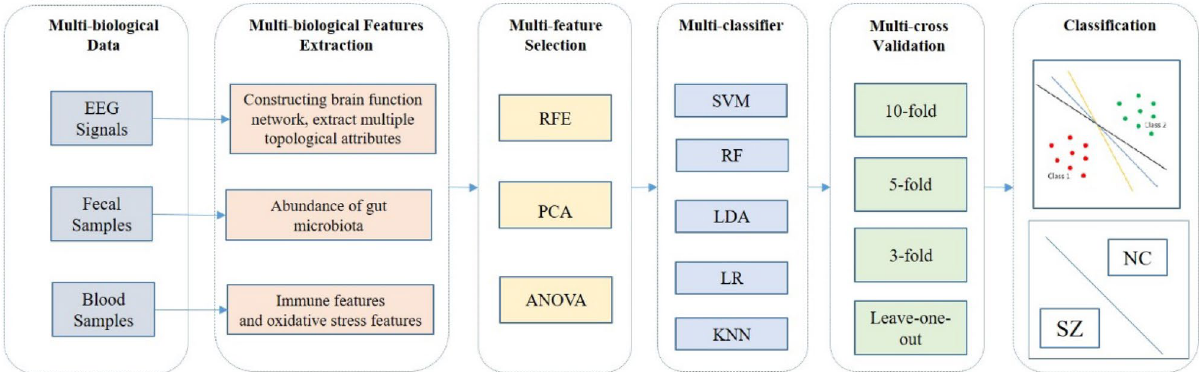
Figure 2. Overview of the proposed integrated machine learning framework for classifying schizophrenia. The proposed integrated machine learning framework for classifying schizophrenia consists of 5 M-methods. ( a ) Multi-biological data were collected from all subjects, including electroencephalogram (EEG) data, fecal data and blood data. ( b ) Multi-biological features were extracted from multi-biological data. ( c ) Multi-feature selection algorithms were used to eliminate redundant features, including recursive feature elimination (RFE), principal component analysis (PCA), and analysis of variance (ANOVA) ( d ) Multi-classifier were used to match heterogeneous biological features including support vector machine (SVM), random forest (RF), linear discriminant analysis (LDA), logistic regression (LR), and k-nearest neighbor (KNN) methods. ( e ) Multi-cross validation methods including tenfold, fivefold, threefold, and leave-one-out methods, were used to evaluate the performance of the trained model.